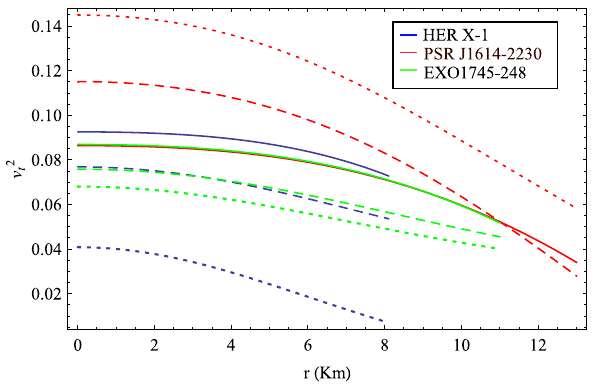
Fig. 7 Radial variation of square of the tangential sound velocity ( v 2 t ) for different compact objects as indicated in the figure. Here plots with solid,dashedanddottedlinescorrespondto D = 4 , 5and6respectively. To obtain the plots we choose (i) α = 0 . 4, γ = 0 . 45 when D = 4; α = 0 . 3, γ = 0 . 25 when D = 5 and α = 0 . 25, γ = 0 . 2 when D = 6 for HER X-1, (ii) α = 0 . 4, γ = 0 . 5 when D = 4; α = 0 . 3, γ = 0 . 25 when D = 5 and α = 0 . 2, γ = 0 . 15 when D = 6 for PSR J1614-2230, (iii) α = 0 . 4, γ = 0 . 5 when D = 4; α = 0 . 3, γ = 0 . 2 when D = 5 and α = 0 . 2, γ = 0 . 25 when D = 6 for EXO1745-248